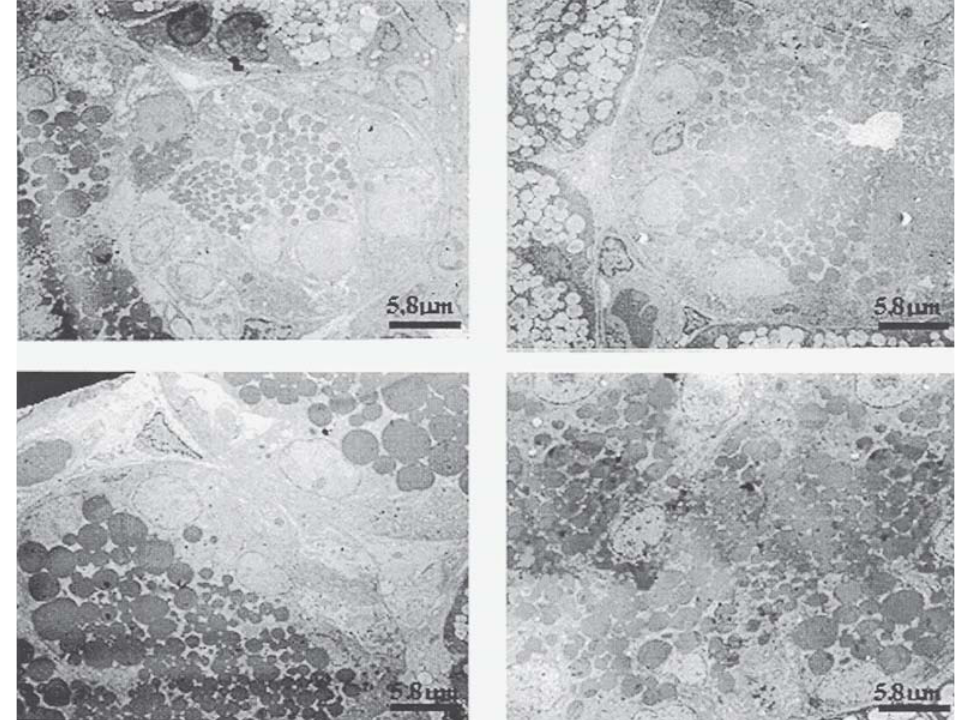
FIGURE 4- (A) Serous cells from the irradiated group at 72 h after irradiation. (B) Serous cells from the sodium selenite group at 72 h. (C) Serous cells from the sodium selenite/irradiated group at 72 h. (D) Serous cells from the control